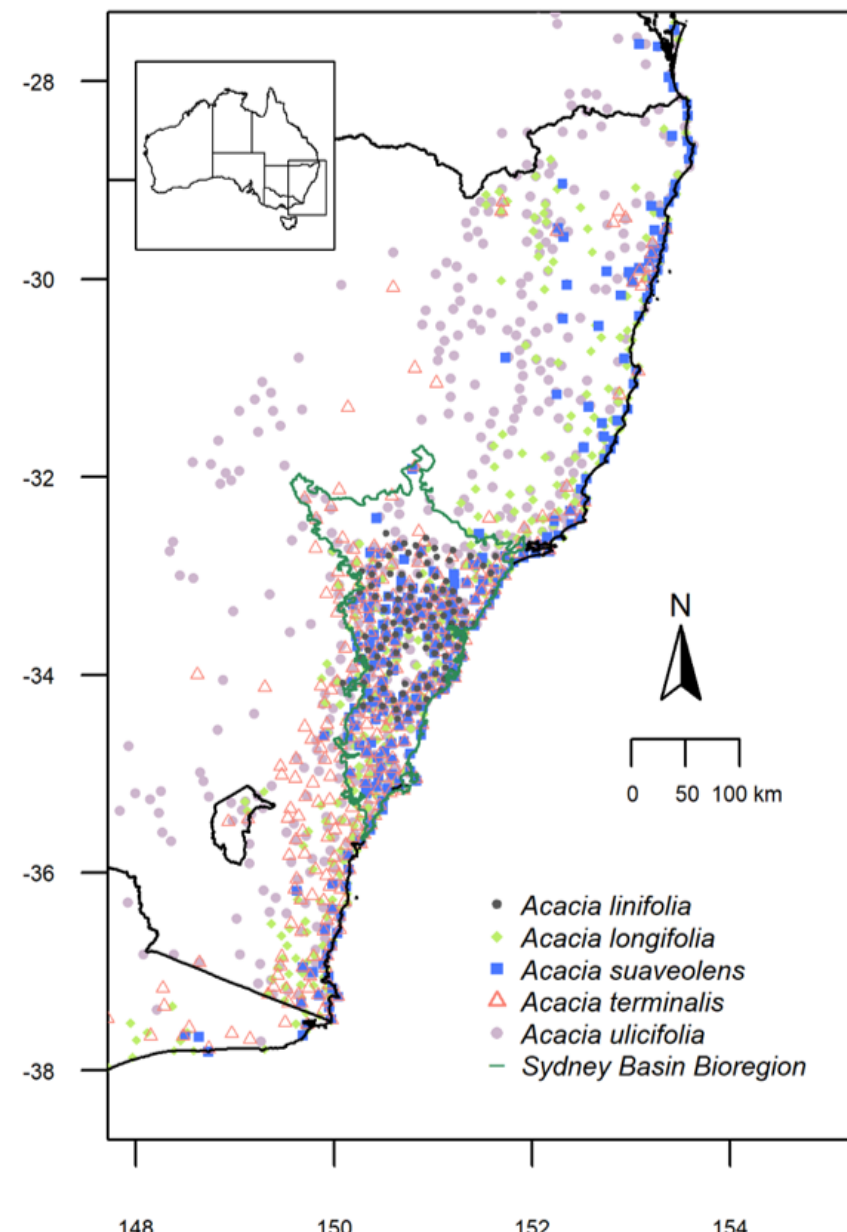
Figure 1. Distribution of the five study species across the study area of eastern Australia.